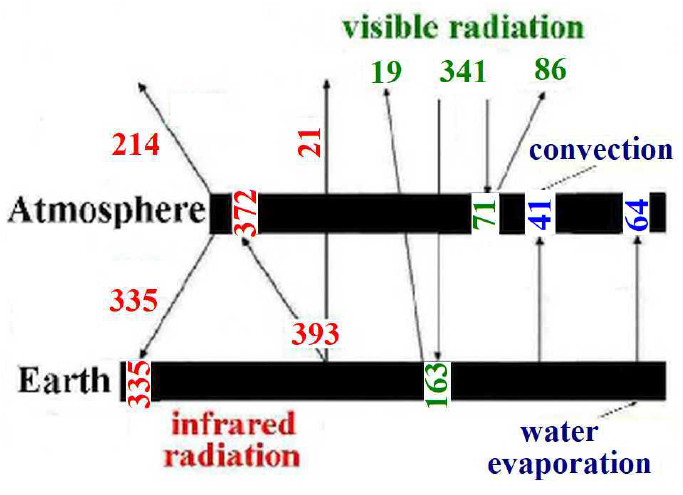
Figure 6. Energetic balance of the Earth and its atmosphere in the form of average energy fluxes expressed in W/m 2 for indicated channels [30]. The absorbed energy fluxes are given inside the corresponding rectangles. The values of the energy fluxes themselves are given near the